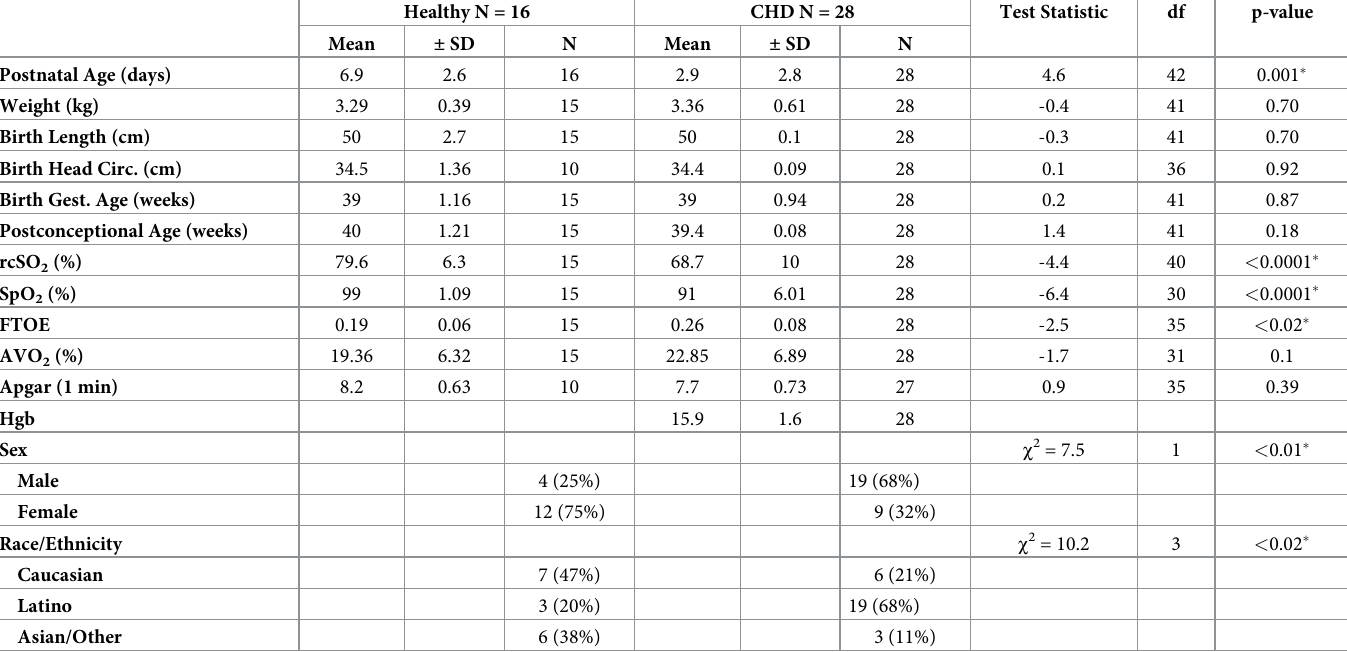
Table 1. Infant demographics and physiologic measures. Healthy N = 16 CHD N =